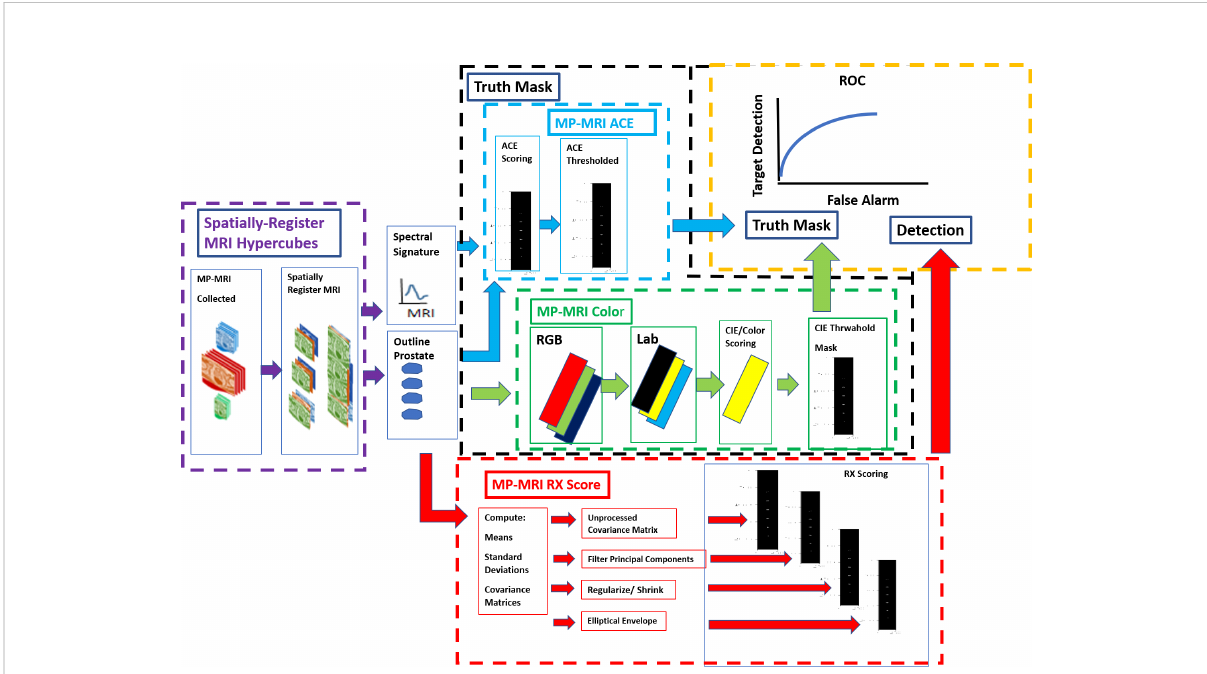
FIGURE 1 Schematic overview of processes that need to generate ROC curve (yellow outline). A spatially registered hypercube (purple outline, arrow) is composed of MRI modalities. Reference mask options include ACE (blue outline) and CIELAB (green outline). Detection map from the RX computation (red outline,